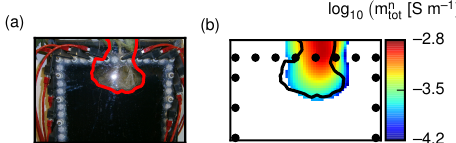
Figure 10. Comparison of root extension inferred from the photo- graph (a) , indicated by overlaid solid lines, and (b) m n tot results for the first time step. In (b) only pixels from the root zone, i.e., pix- els with a polarization response above the identified σ (cid:48)(cid:48) threshold value, are